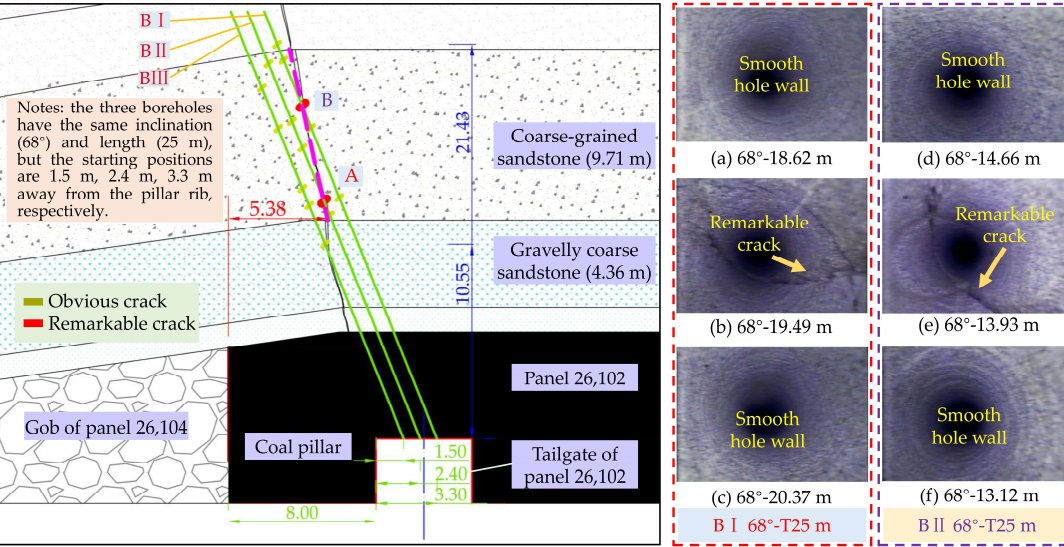
distribution of cracks propagation in the roof strata of 26,102 tailgate is shown in Figure 6, indicated that: (1) most of the cracks were distributed between 10.55 m and 21.43 m above the coal pillar, that is, the range of main roof thickness. (2) Remarkable longitudinal cracks with intersecting circumferential cracks occurred at depths of 19.49 m in BII and 13.93 m in BII, indicating that the main floor had been fractured. The borehole wall within 1 m of the two cracks sites was relatively intact again, so it could be deduced that the fracture line of the main roof was located above the coal pillar. (3) Based on the angles and depths of the boreholes where the two remarkable cracks were observed, the position of fracture line in the main roof was 5~6 m away from the edge of the gob, which was con- sistent with the theoretical calculation result. Figure 5. Site construction. ( a ) Layout of part boreholes in roof. ( b ) Crawler drill. The obvious crack was defined by a width over 5 mm and a length over 10 mm, and the remarkable crack was defined by a width over 10 mm and a length over 100 mm. The